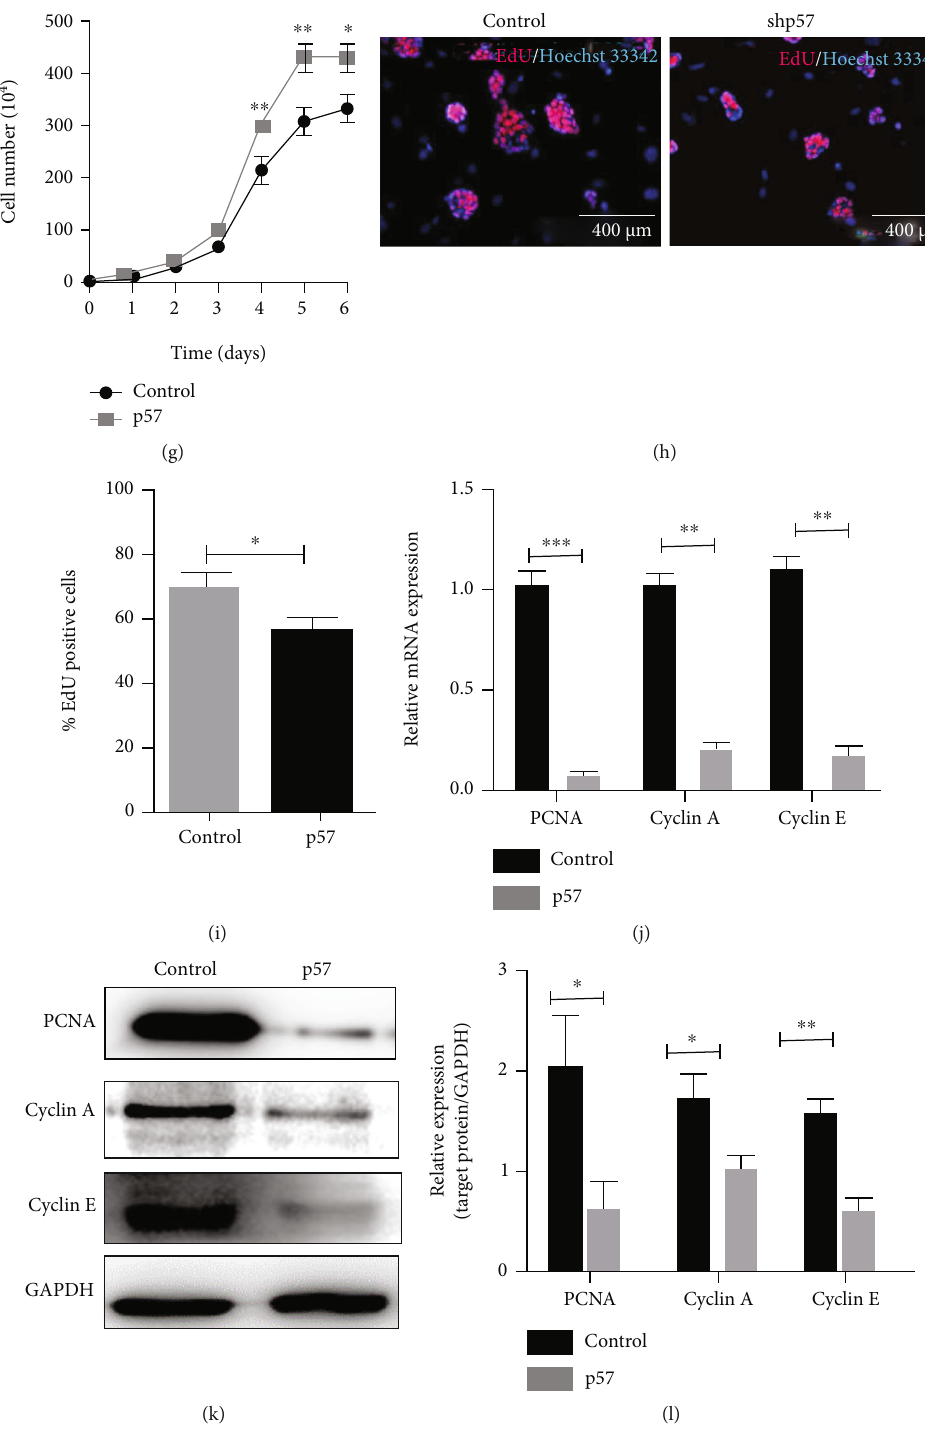
Figure 4: p57 suppressed the proliferation of mESCs. (a) The growth curve of control ( n = 5 ) and p57 knockdown (shp57, n = 5 ) mESCs. (b, c) EdU staining results of control ( n = 5 ) and p57 knockdown (shp57, n = 5 ) mESCs cultured for 48 h. (d) Real-time PCR analyses of pcna , Cyclin A , and Cyclin E expression levels of control ( n = 3 ) and p57 knockdown (shp57, n = 3 ) mESCs cultured for 48h. (e, f) Western blot and related densitometric analysis of PCNA, Cyclin A, and Cyclin E protein levels of control and p57 knockdown (shp57) mESCs cultured for 48 h. (g) The growth curve of control ( n = 5 ) and p57-overexpressing (p57, n = 5 ) mESCs. (h, i) EdU staining results of control ( n = 5 ) and p57-overexpressing (p57, n = 5 ) mESCs cultured for 48 h. (j) Real-time PCR analyses of pcna , Cyclin A , and Cyclin E expression levels of control ( n = 3 ) and p57-overexpressing (p57, n = 3 ) mESCs cultured for 48h. (k, l) Western blot and related densitometric analysis of PCNA, Cyclin A, and Cyclin E protein levels of control and p57-overexpressing (p57) mESCs cultured for 48 h. Scale bar = 400 μ m. ∗ P < 0 : 05 , ∗∗ P < 0 : 01 , and ∗∗∗ P < 0 : 001